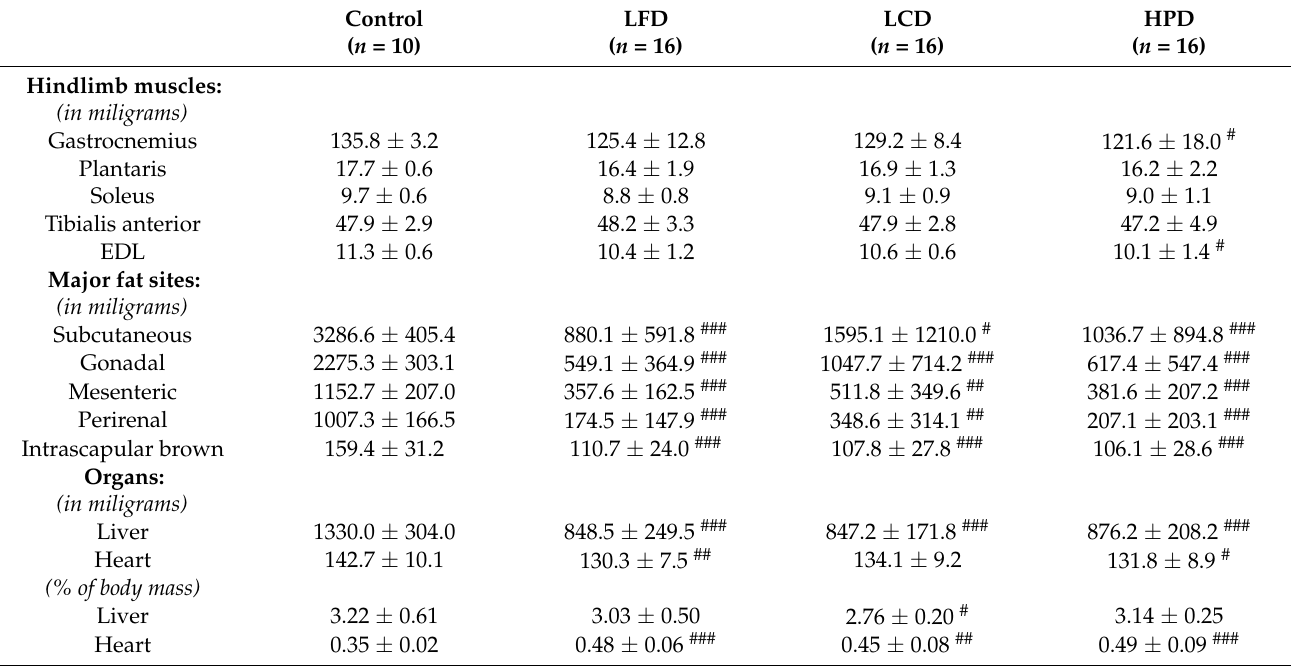
Table 2. Weights of isolated hindlimb muscles, fat from different sampling sites and liver as well as heart after a 6-week caloric restriction on low-fat (LFD), low-carbohydrate (LCD) or high-pro (HPD) diets compared to the age-matched control group on obesogenic